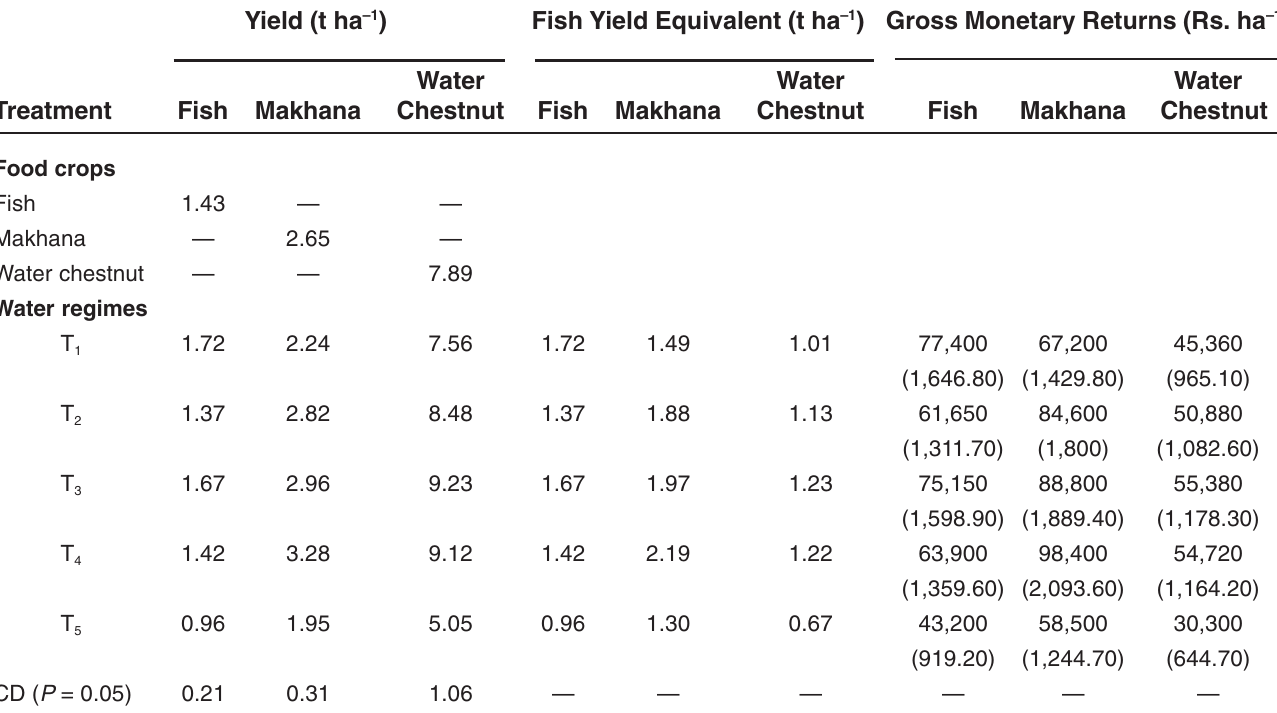
Fish, Nut Yield, Fish Yield Equivalent, and Monetary Return of the